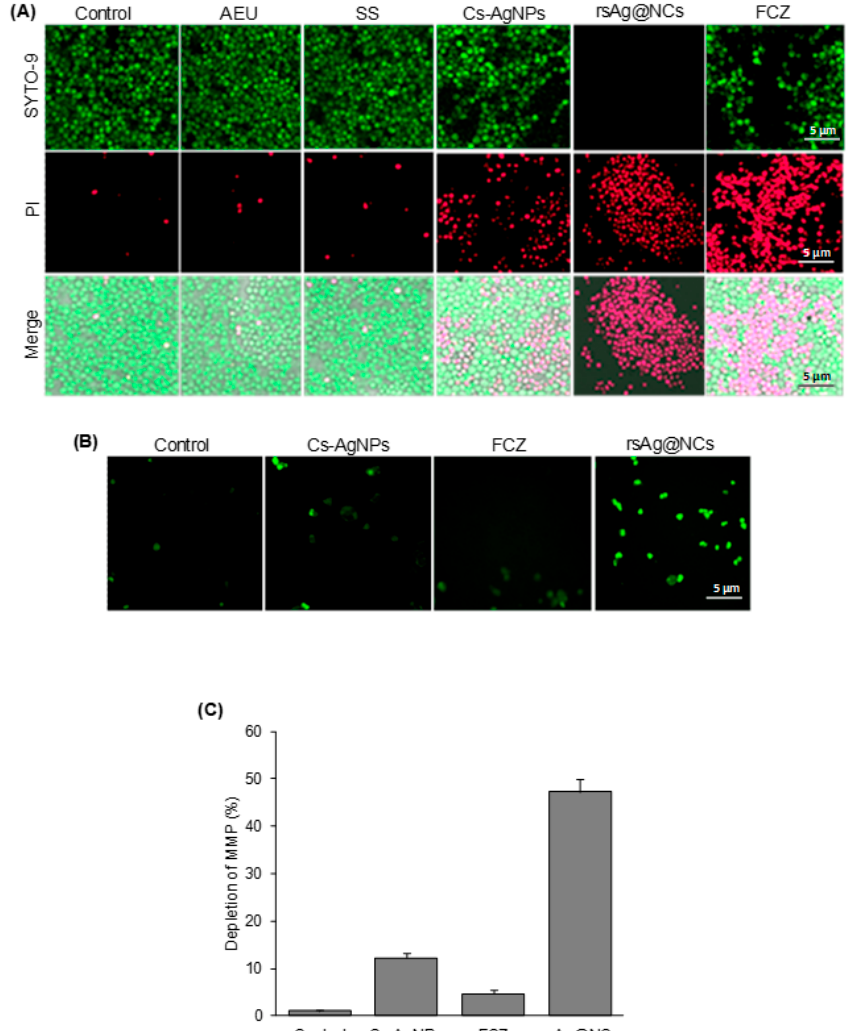
Figure 2. Effect of rsAg@NCs on the viability of C. albicans NBC099 and intracellular reactive oxygen species (ROS) accumulation. ( A ), Cells of NBC099 (2 × 10 5 /mL) were seeded on a glass cover slip in species (ROS) accumulation. (A), Cells of NBC099 (2 × 10 5 /mL) were seeded on a glass cover slip in the presence of the indicated treatments: AEU (200 µ g/mL), silver nitrate solution (SS; 10 µ g/mL), the presence of the indicated treatments: AEU (200 µg/mL), silver nitrate solution (SS; 10 µg/mL), Cs-AgNPs (10 µ g/mL), FCZ (60 µ g/mL), and rsAg@NCs (10 µ g/mL) for 24 h at 37 ◦ C. Cell Cs-AgNPs (10 µg/mL), FCZ (60 µg/mL), and rsAg@NCs (10 µg/mL) for 24 hr at 37 °C. Cell viability